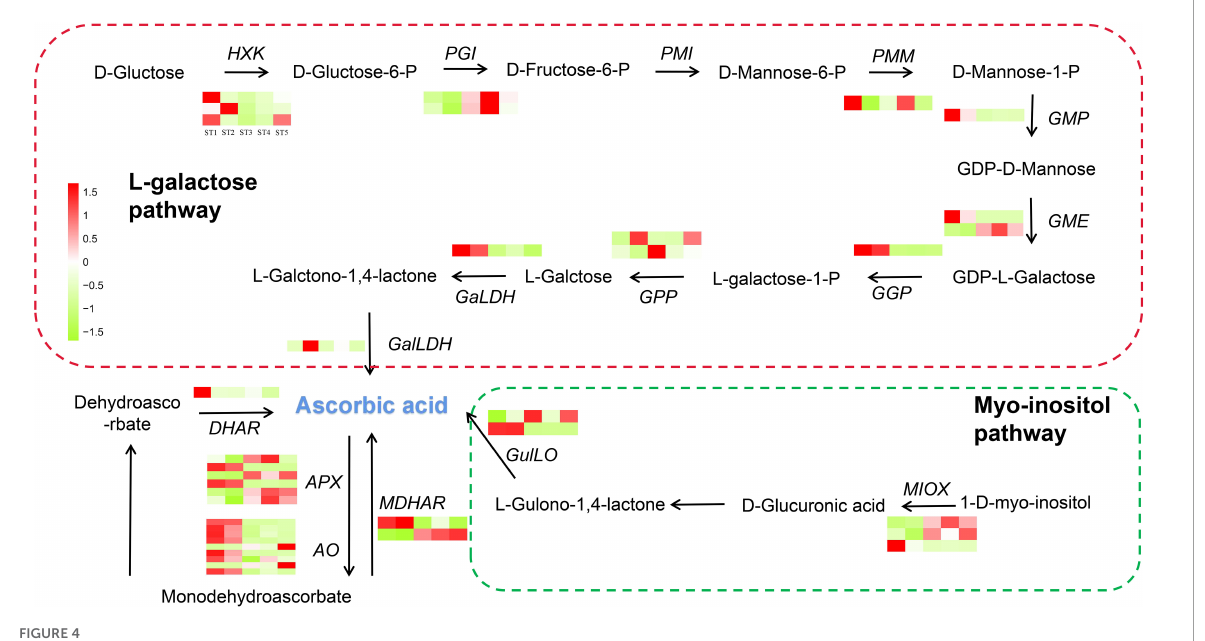
FIGURE4 The map of AsA biosynthetic and recycling